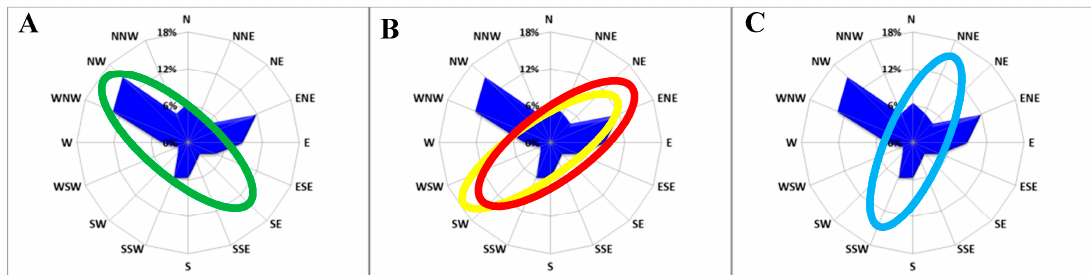
Figure 2. Percentage of prevailing wind directions on the Calypsostranda area (NW Wedel Jarlsberg Land) before and during the sampling campaign (13.07–08.08.2012). Circles represent the sampling site exposure to wind: A —Logne Valley; B —intra-marginal zones of the Scott and Renard glaciers; C —extra-marginal zone of Antonia Glacier.